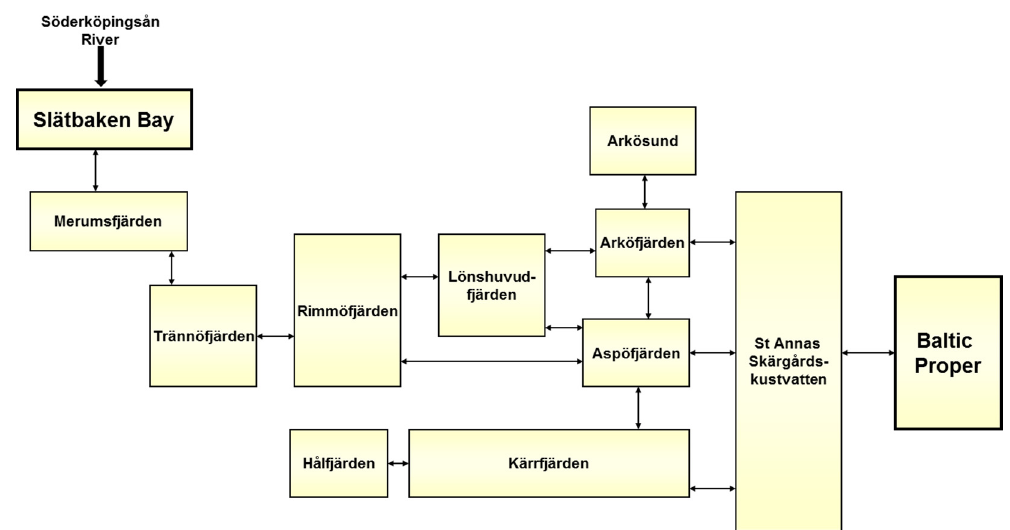
Figure 2. The CZM set-up in the St Anna archipelago, showing the Slätbaken Bay and the water exchange with surrounding basins and eventually the Baltic